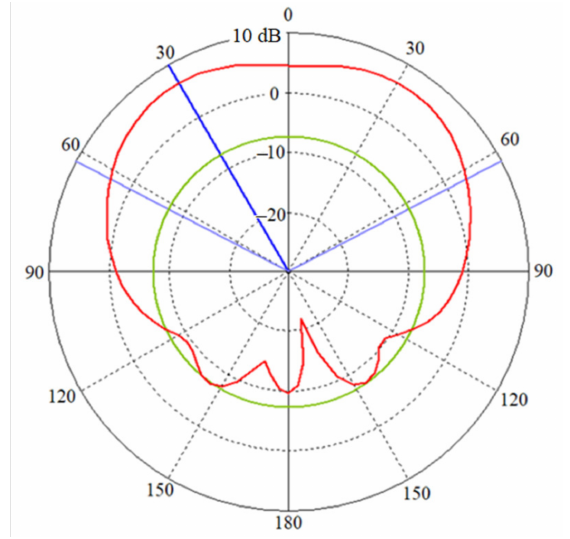
Figure 12. Simulated radiation pattern E-plane at 5.0 GHz.